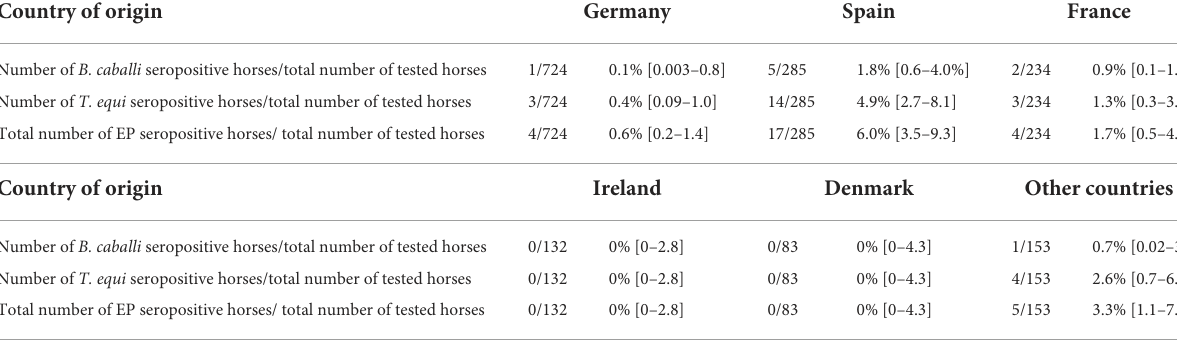
TABLE 2 Total numbers of seropositive horses for B. caballi, T. equi and combined (“EP seropositive”) compared to the total of horses tested between 2015 through to 2020 per category based on microchip numbers and country codes. Country of